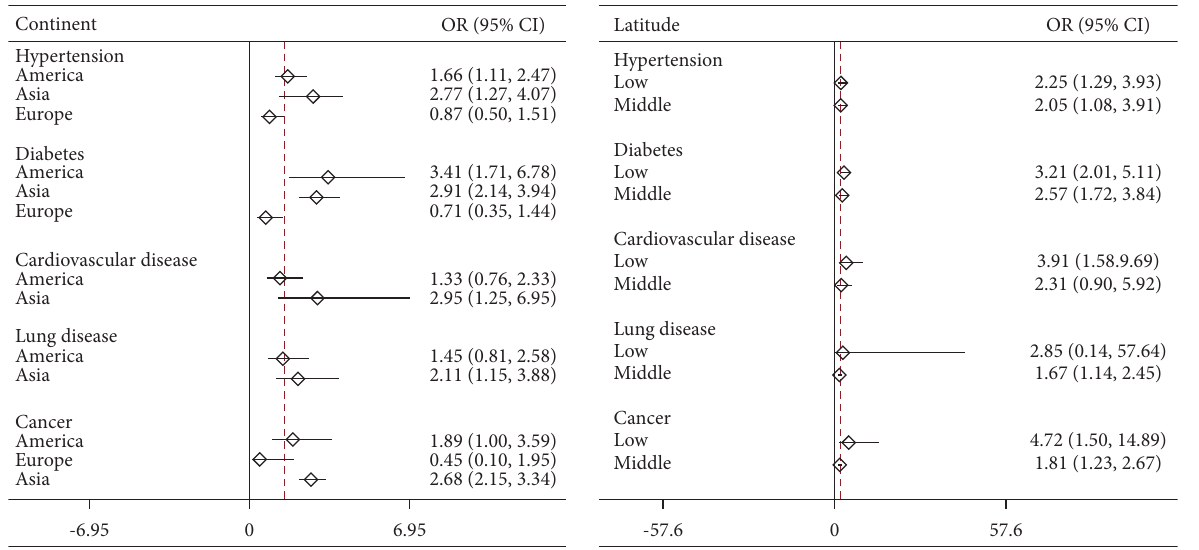
Figure 5: Comparison of the comorbidities of mild and severe COVID-19 patients in different areas. Hypertension includes primary hypertension and secondary hypertension; diabetes includes type 1 diabetes and type 2 diabetes; cardiovascular disease includes coronary artery disease, arrhythmia, congestive heart failure; lung disease includes COPD, asthma, obstructive sleep apnea; cancer includes all kinds of cancer.